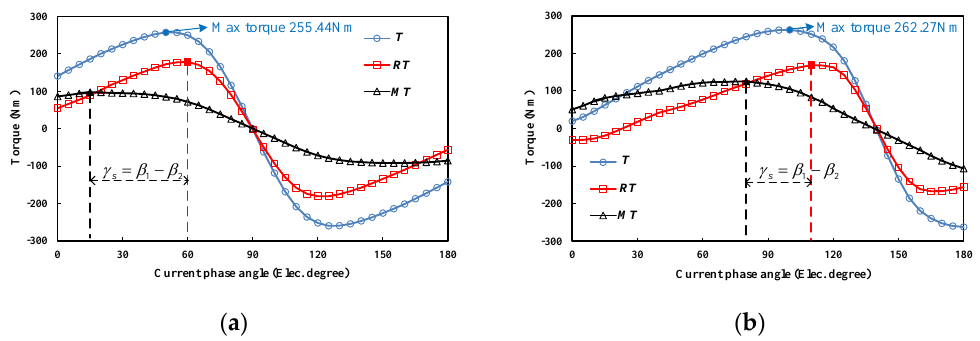
Figure 9. The torque component segregation. ( a ) The Prius 2010 IPM machine. ( b ) The MAS-IPM machine.